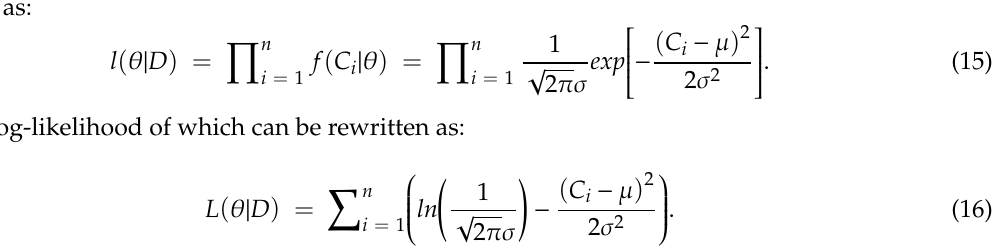
Figure 4. Simulated safety factors of the 750